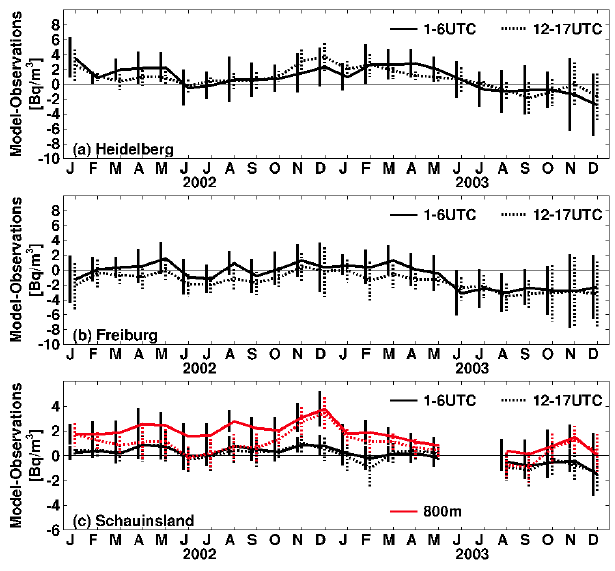
Fig. 6. Monthly mean and standard deviations of mismatch de- fined as simulated minus measured concentrations for Heidelberg (a) , Freiburg (b) and Schauinsland (c) estimated in midnight to dawn hours (01:00–06:00UTC, dashed line) and in afternoon hours (12:00–17:00UTC, solid line) for 2002 and 2003. Measured con- centrations are subtracted from the ensemble mean of fourteen model outputs. Vertical line indicates one standard deviation of 6 hourly mean of mean model. Statistics obtained at 800m are shown in